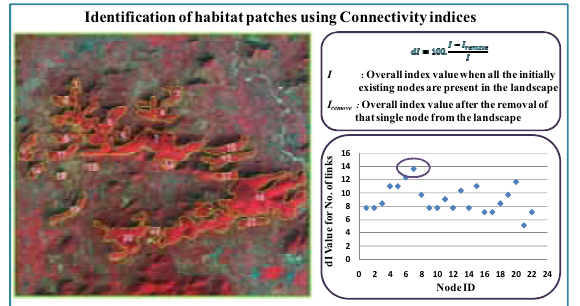
Figure 3: Connectivity indices analysis output showing the node importance value (dI) with reference to link i.e., Graph is showing the importance (dI) of an existing node (node 7) for maintaining landscape connectivity in accordance with the number of links.